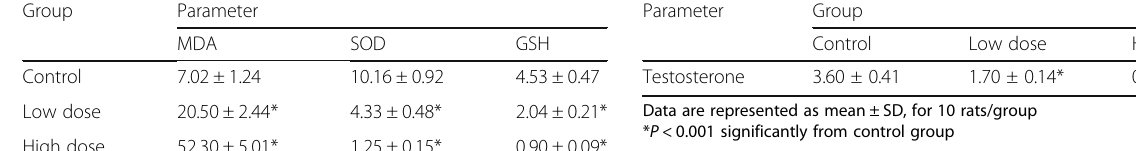
Table 1 The effect of BPA on the liver MDA, SOD, and GSH level Group Parameter